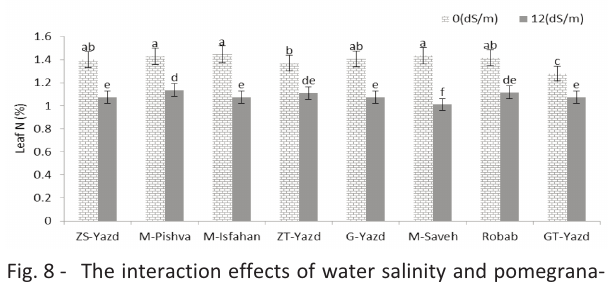
Fig. 8 ­ The interaction effects of water salinity and pomegrana­ te cultivars on leaf nitrogen